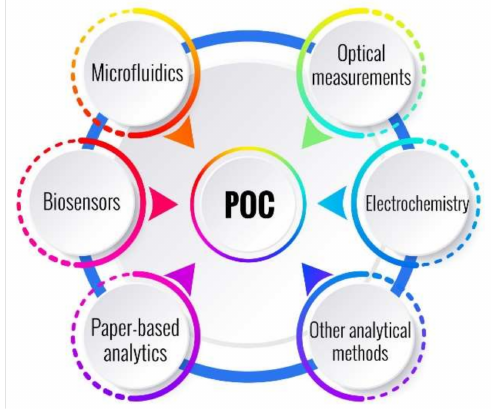
Figure 1. Generalization of the Venn diagram proposed by Rackus et al. [1]. It shows the interaction of biosensors, microfluidics, and different technologies and analytical methods, which gives rise to POC